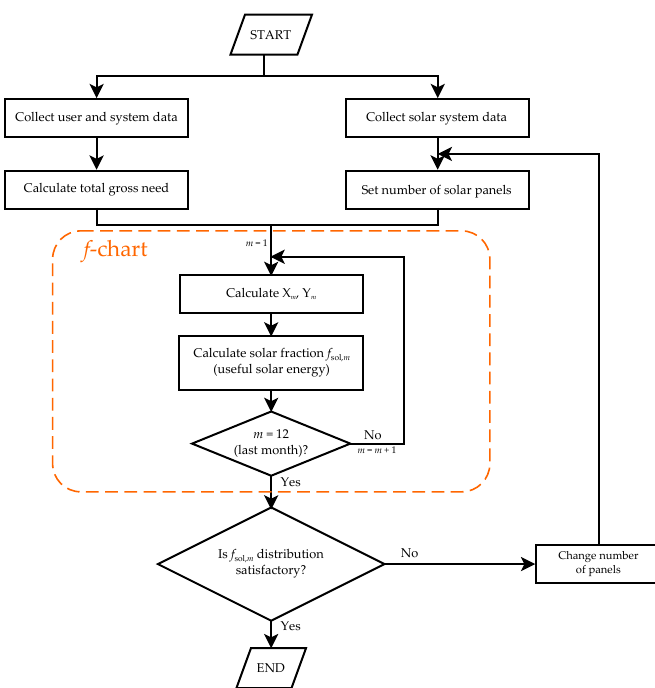
Figure 2. Diagram for the use of f -chart method to determine monthly solar fraction for sizing purpose.